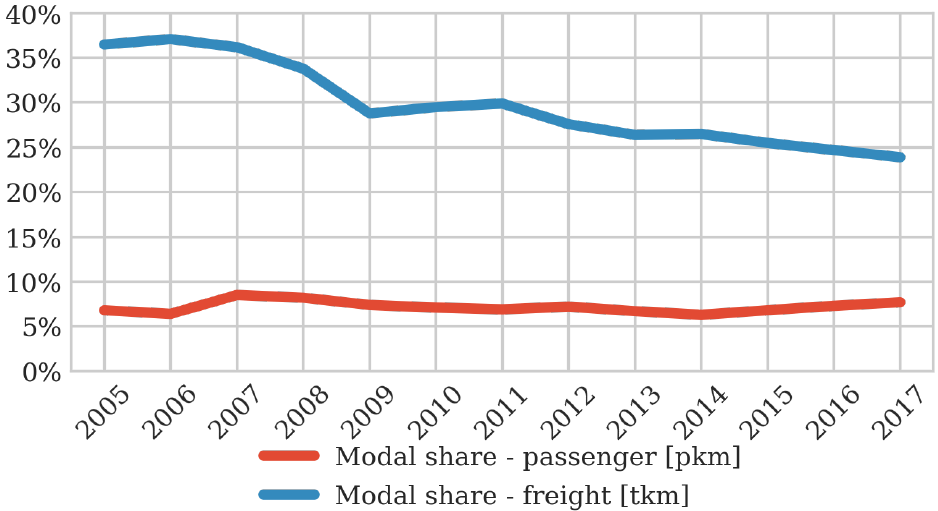
Figure 8. Dynamics of modal share of railway transportation in Poland. Own study based on data from